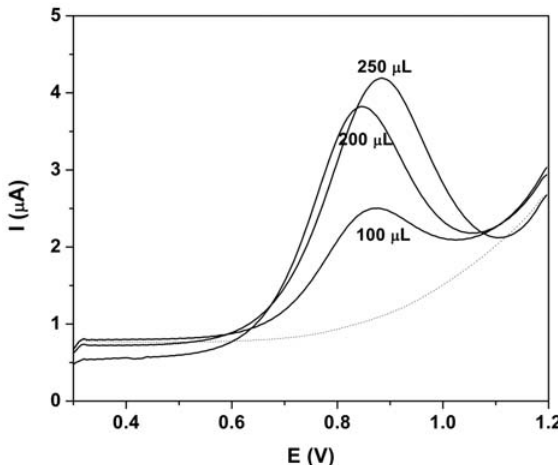
Figure 5. SW voltammograms of a velvet bean extract recorded with a BDDE for different sample volumes (100, 200 and 250 μL in 10 mL of total volume) by the proposed electroanalytical method under optimized conditions.